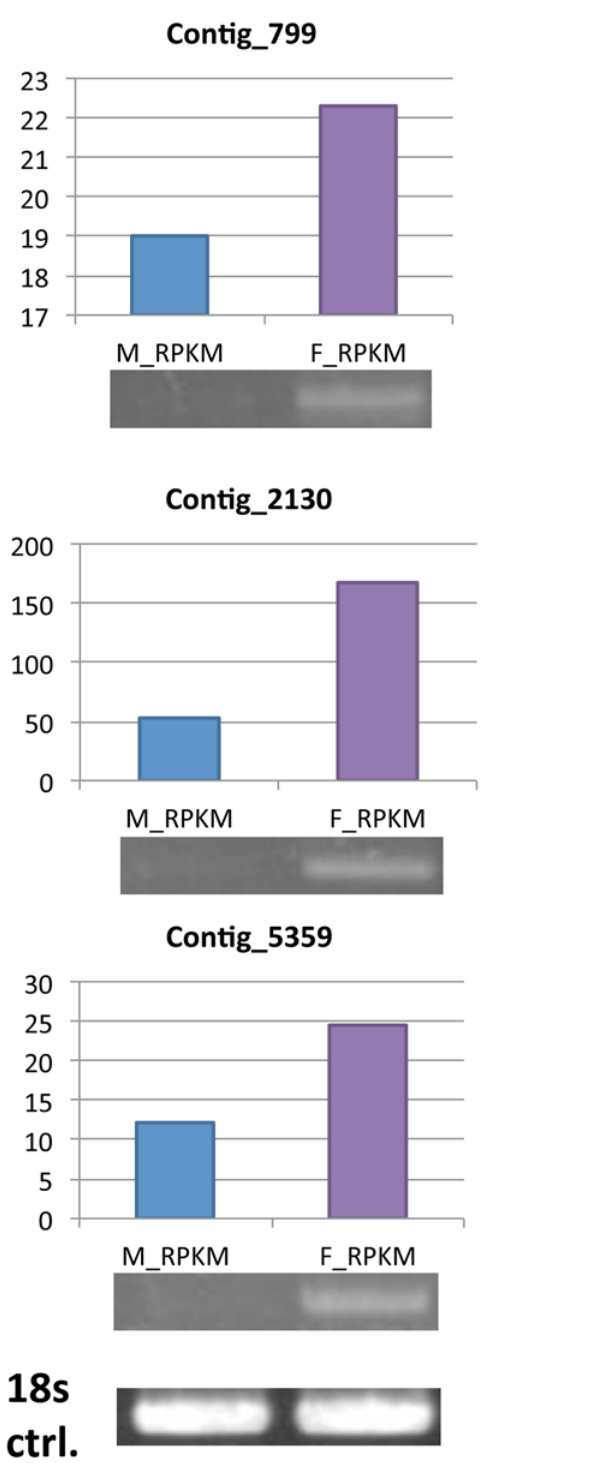
Fig 6. RT-PCR of DCL-2 (Contig_799), QDE-2 (argonaute protein, Contig_2130), DCL-1 (Contig_5359) and 18s rRNA genes in A . cinnamomea .